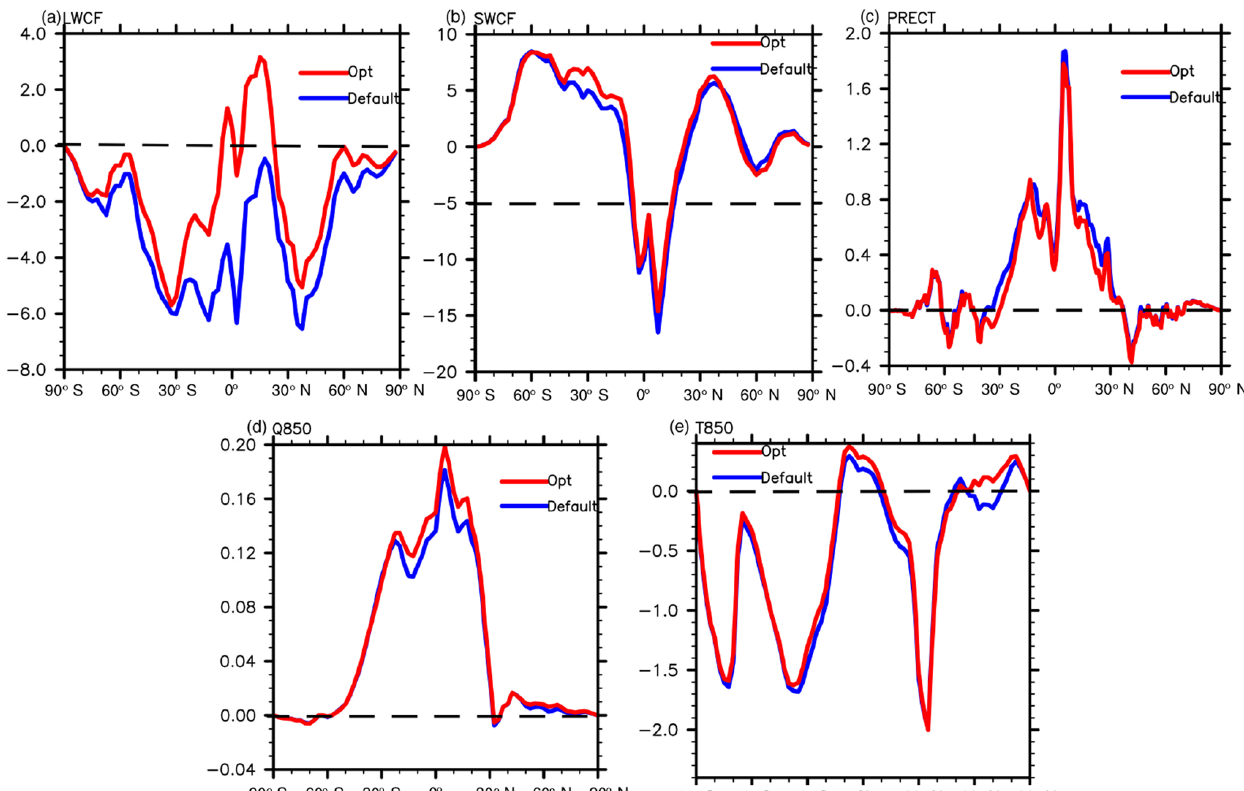
Figure 7. Meridional distribution of the AMIP difference between EXP/CNTL and observations of LWCF (a) , SWCF (b) , PRECT (c) , Q850 (d) , and T850 (e) . The red line is the output variable of EXP. The blue line is the output variable of